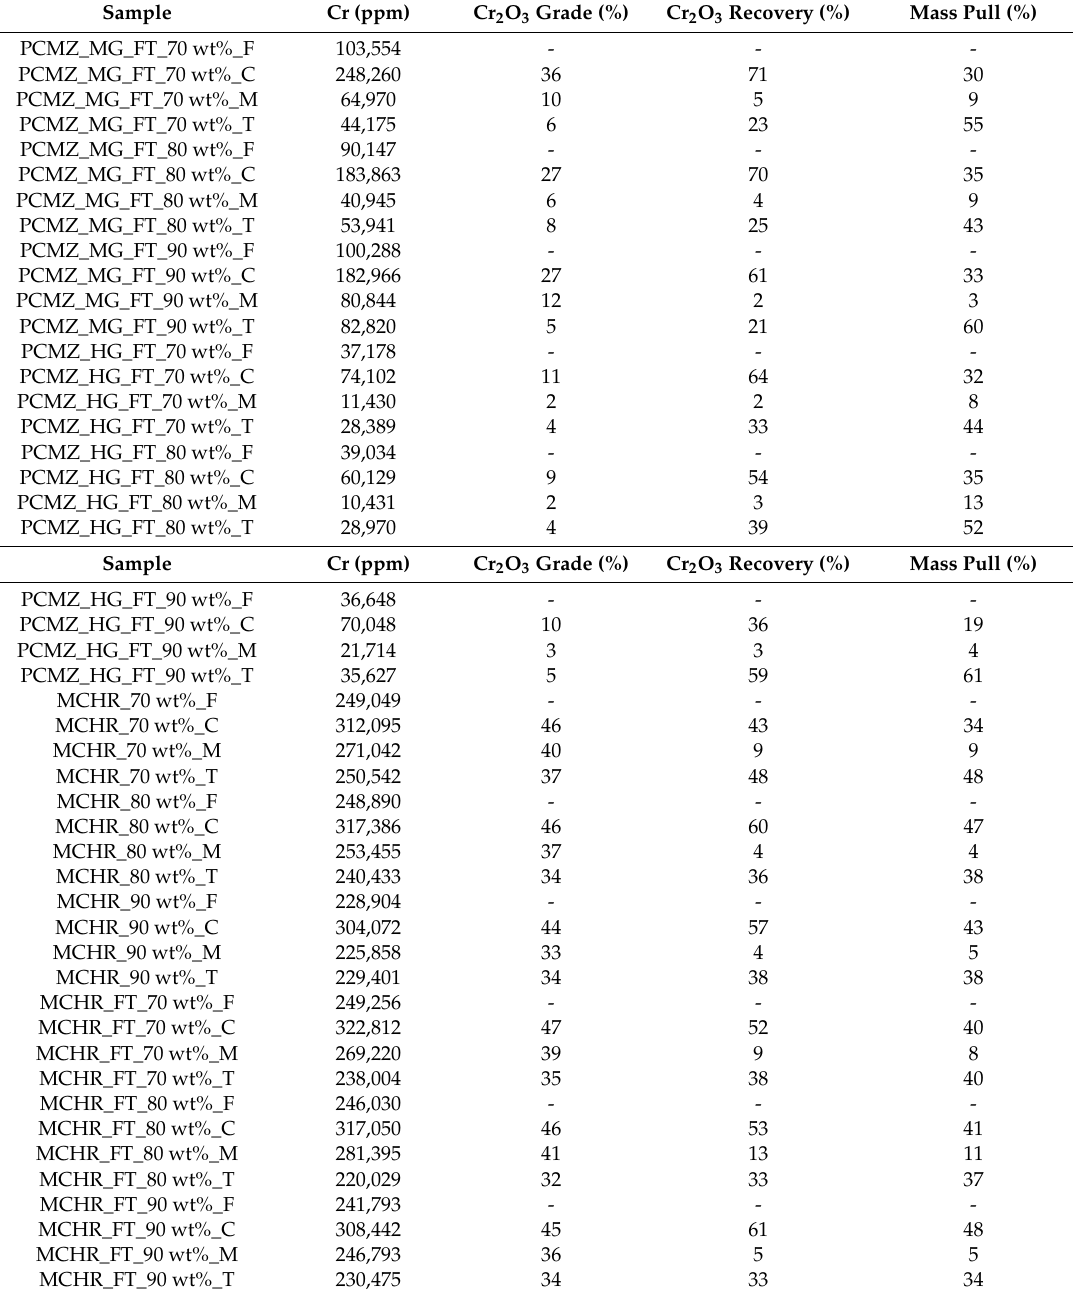
Table 4. Chromite assays of the three ores including chromite recovery and mass pulls based